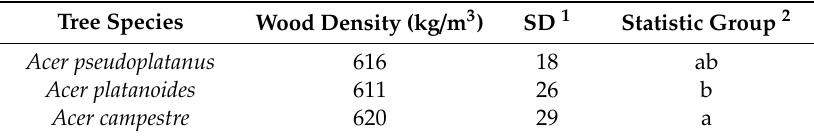
Table 3. Average wood density and standard deviation of three maple species. Tree